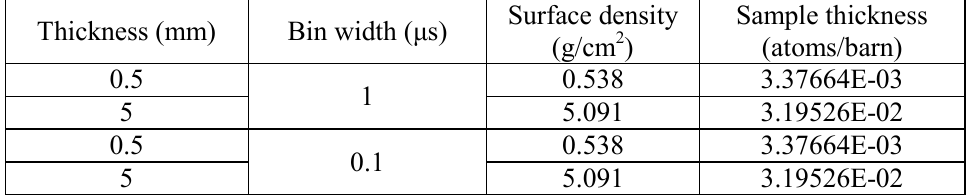
Table II. Characteristics of the Mo samples for transmission